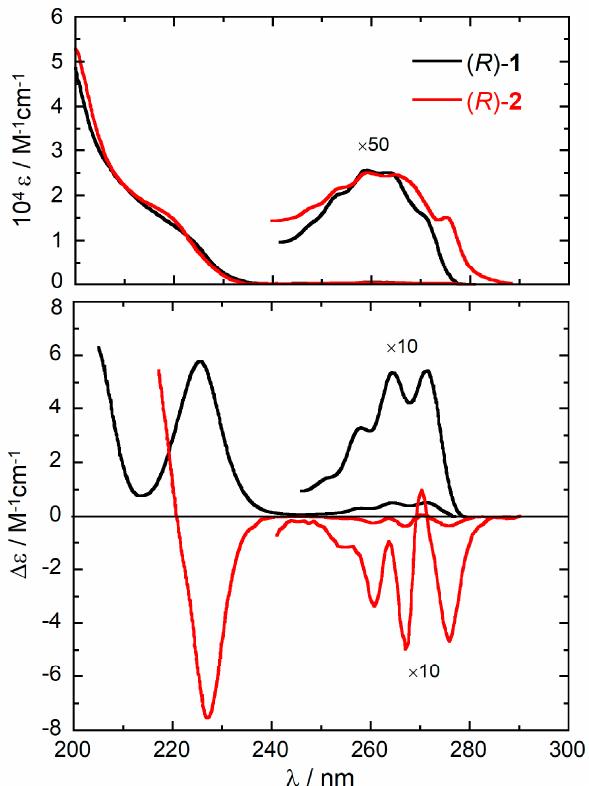
Figure 1. Experimental UV ( top ) and ECD ( bottom ) spectra of ( R )- 1 (black lines) and ( R )- 2 (red lines) recorded in ethanol. Reproduced from Ref. [28] with permission of Taylor & Francis Ltd., www.tandfonline.com.